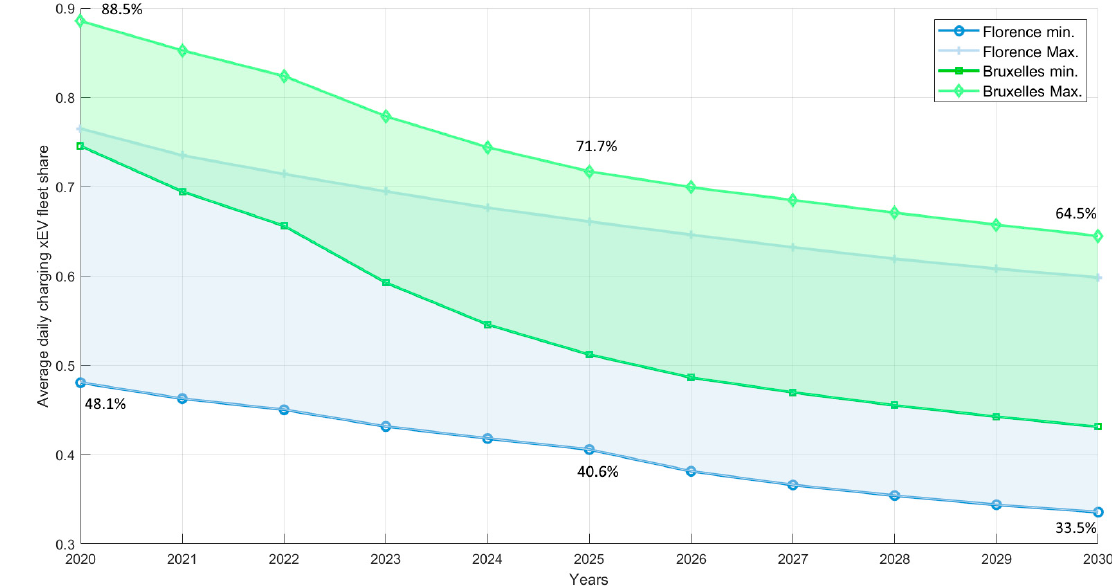
Figure 10. Publicly accessible charging infrastructure daily charging events for Florence (light blue) and Bruxelles (light green).